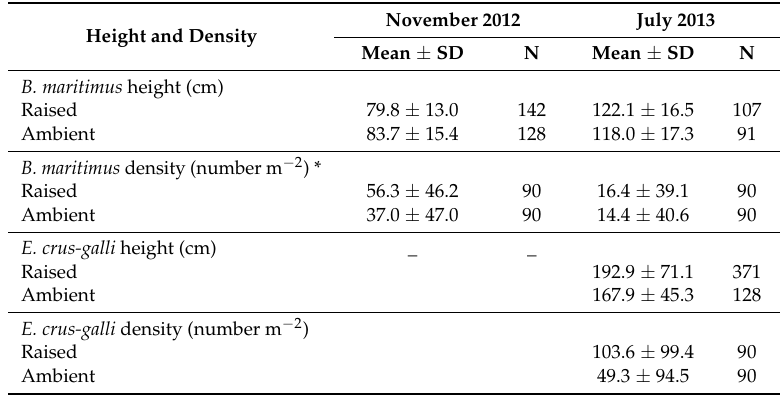
Table 1. Height and density of Bolboschoenus maritimus culms and Echinocloa crus-galli in 0.09-ha test cells subjected to two hydroperiod